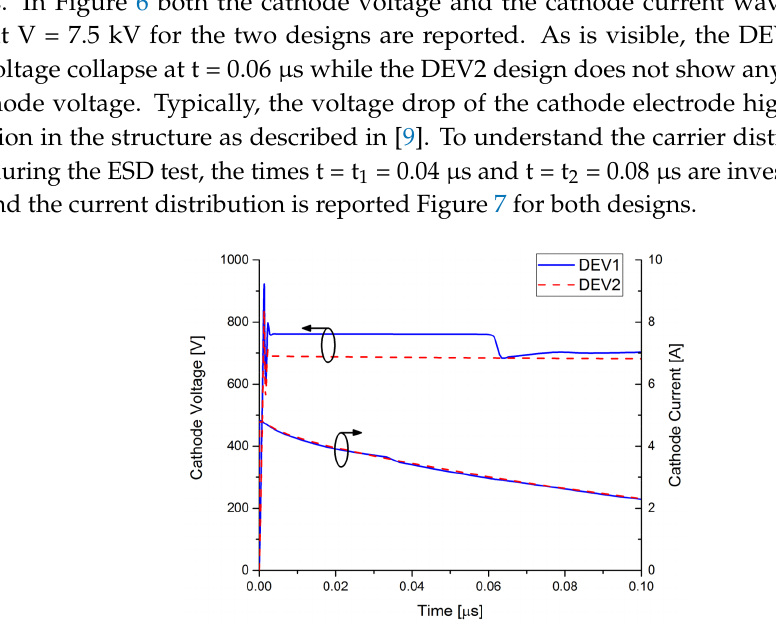
Figure 6. Numerical cathode voltage and current waveforms of DEV1 and DEV2 structures during the ESD test (only active area). V C = 725 V.